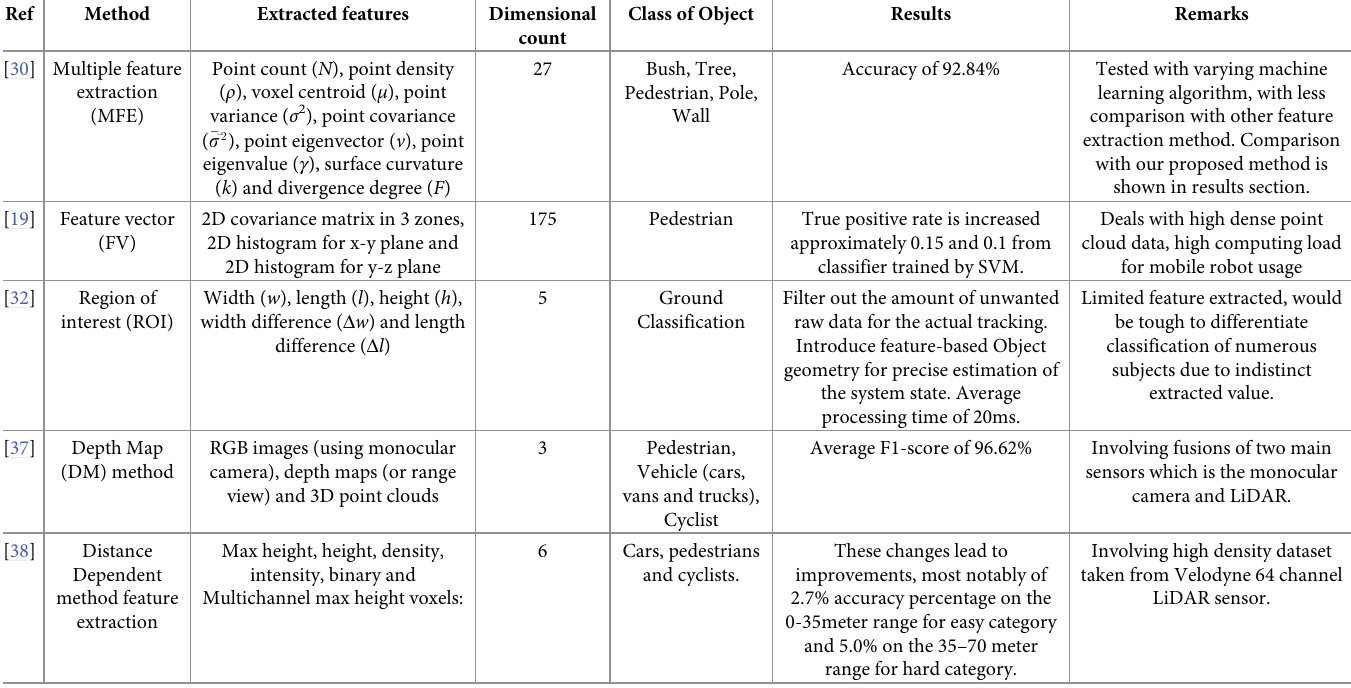
Table 1. Summary of the findings of selected existing